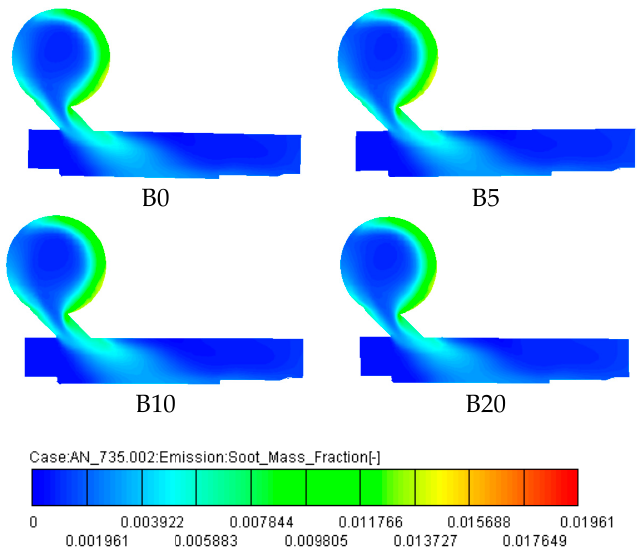
Figure 18. The progress of PM at 39° ATDC at 1400 rpm and 100% load.